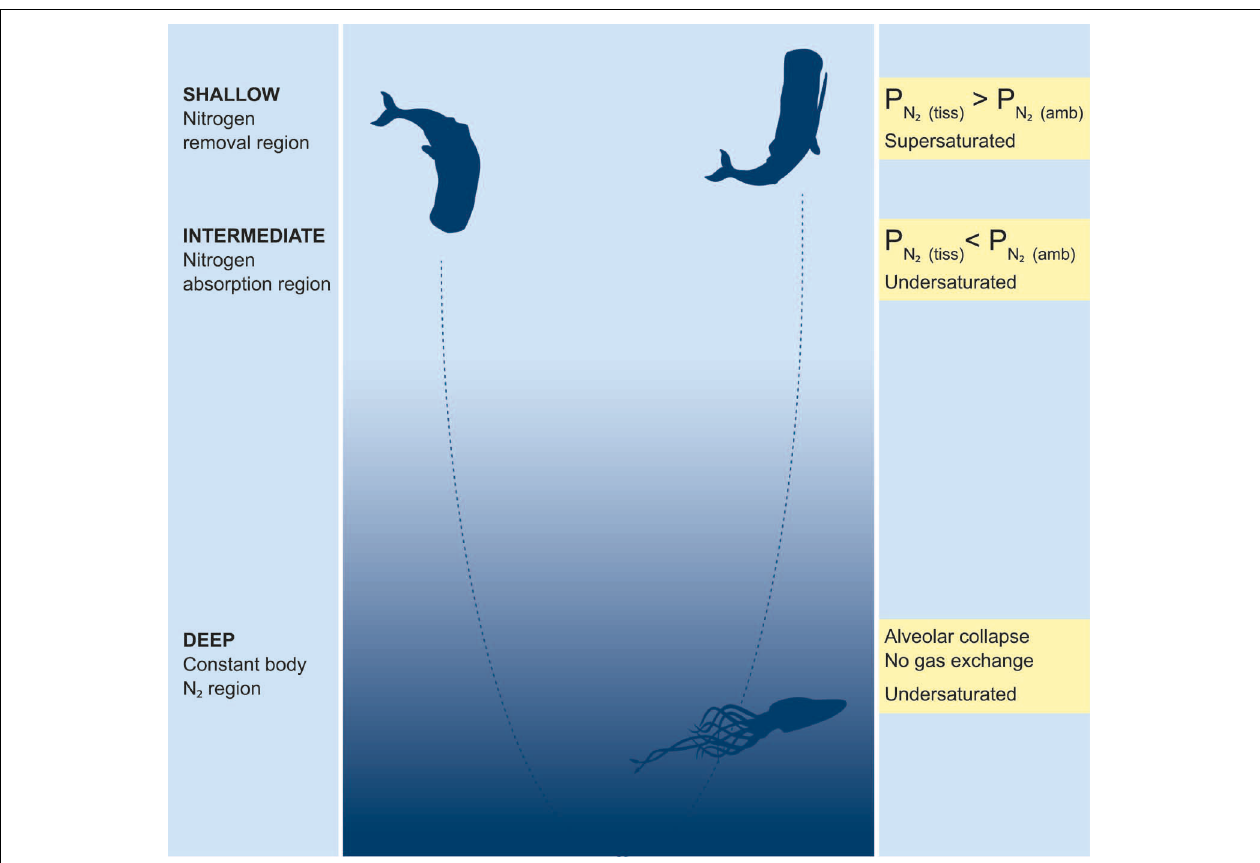
the animal. It might be restricted to just the surface or extend down FIGURE 1 | Conceptual model of risk of gas embolism in deep to depths of 20–30m if the animal has a high P N level built up during diving mammals. The descent and ascent of deep dives goes through 2 previous dives. The risk of gas bubble embolism depends on the three different depth ranges representing different risk of gas bubble in the tissue and the saturation level, which is determined by the P N embolism (Kvadsheim et al., 2012). The Shallow N 2 removal region 2 where N 2 is excreted because the partial pressure of N 2 in the tissue hydrostatic pressure. N 2 levels in the tissue will increase if more time > P is higher than the ambient hydrostatic pressure [P N is spent in the Intermediate N 2 absorption region and less time in the N 2 ( amb ) ], the 2 ( tiss ) Intermediate N 2 absorption region where N 2 is absorbed because the Shallow N 2 removal region. Time spent in the Deep constant body N 2 < region, does not add to the total body nitrogen, but the extended ambient partial pressure of N 2 is higher than in the tissue [P N 2 ( tiss ) ], and the Deep constant body N 2 region where N 2 is neither P N duration of the deep dives allows for transfer of N 2 into poorly 2 ( amb ) absorbed nor excreted in the lungs (no gas exchange) because of perfused slow tissues such as blubber, where it might accumulate to alveolar collapse. The gas exchange model used in this paper suggests dangerous levels. Gas embolism will only occur in supersaturated that the Deep constant body N 2 region starts when the alveoli are tissues and because this requires a low hydrostatic pressure, it only completely collapsed at 180–220m, depending on species, and extend occurs in the Shallow N 2 removal region, including the surface. Thus, the Intermediate N 2 absorption region is where N 2 is absorbed, but the downward as deep as the animal might dive. The depth range of the Shallow N 2 removal region is what represents the immediate risk of Shallow N 2 removal region (decompression zone) will constantly vary level of the tissue, and thus the dive history of depending on the P N gas embolism. See text for further details Illustration IAN, FFI. 2